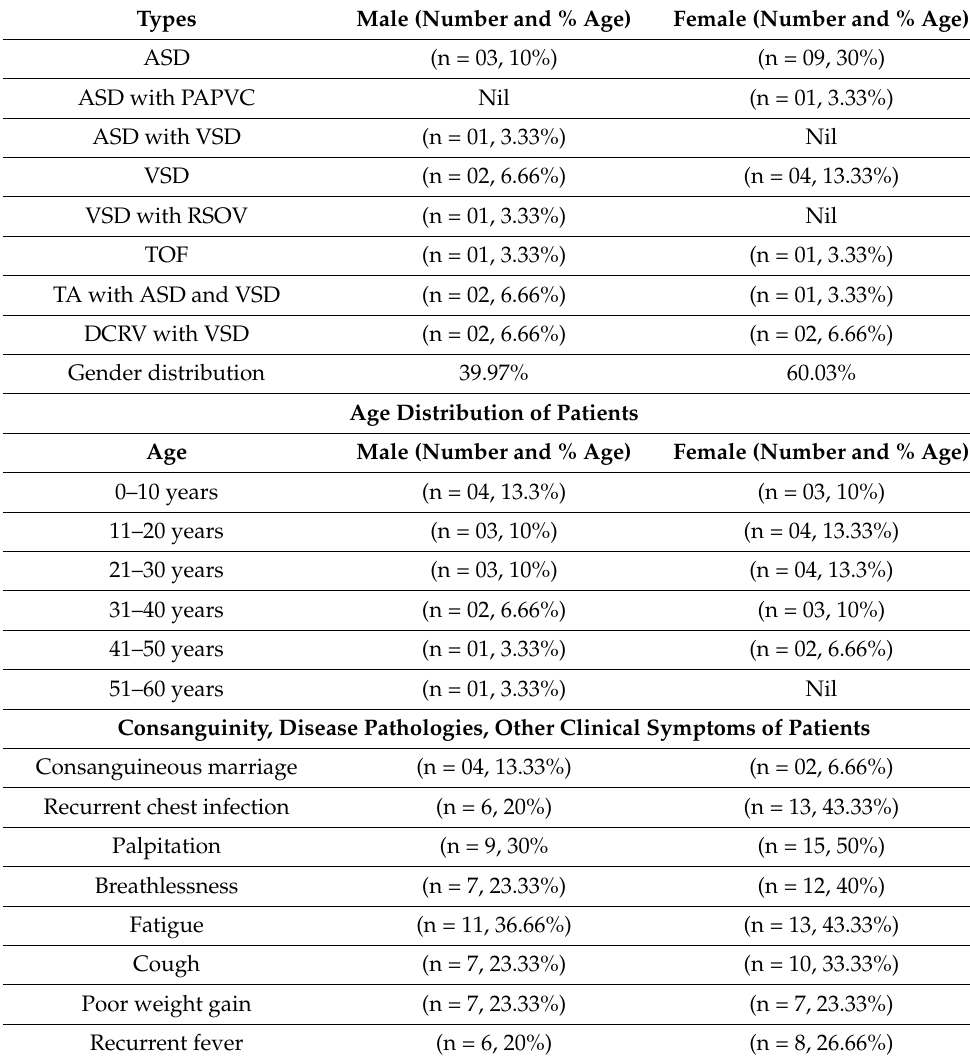
Table 1. Types and sex distribution of different congenital heart disease (n = 30).